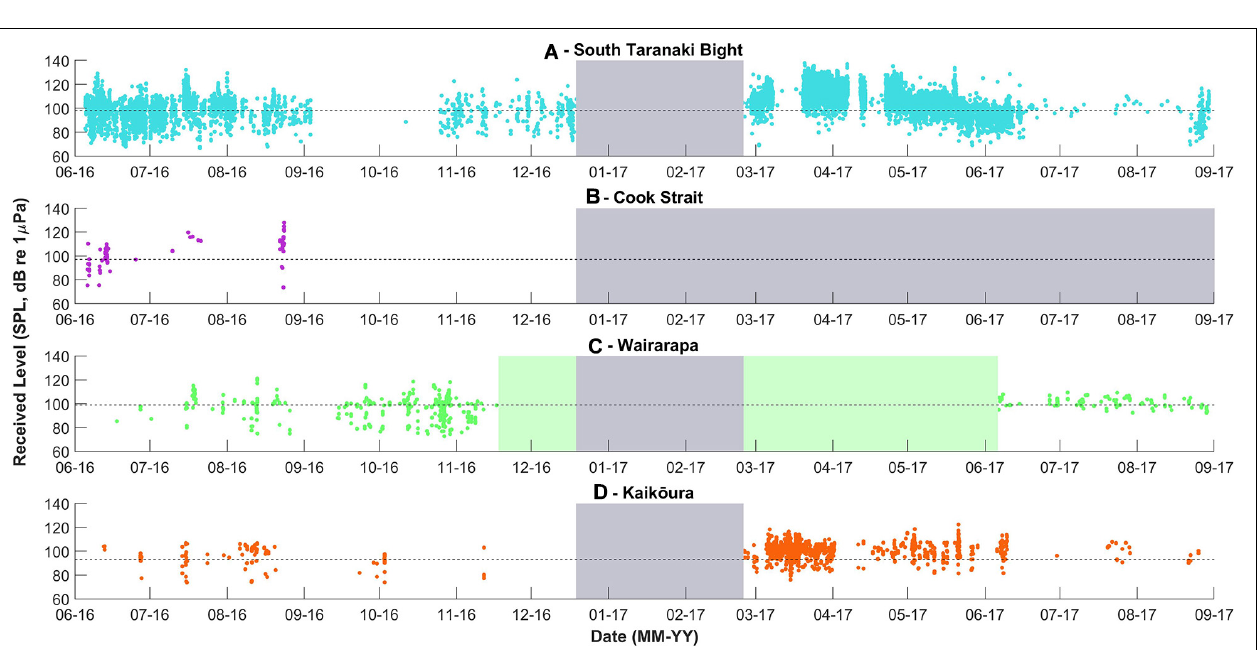
FIGURE 5 | Received levels of Antarctic blue whale calls detected per recording location, over time. Received levels were calculated only for the upper tone (approximately 26 Hz) of each call. The dashed lines indicate the detection threshold associated with an unconditional probability of detection of 50%, the model configuration is described in the Methodology. The grey and green blocks are as described in Figure 3 .